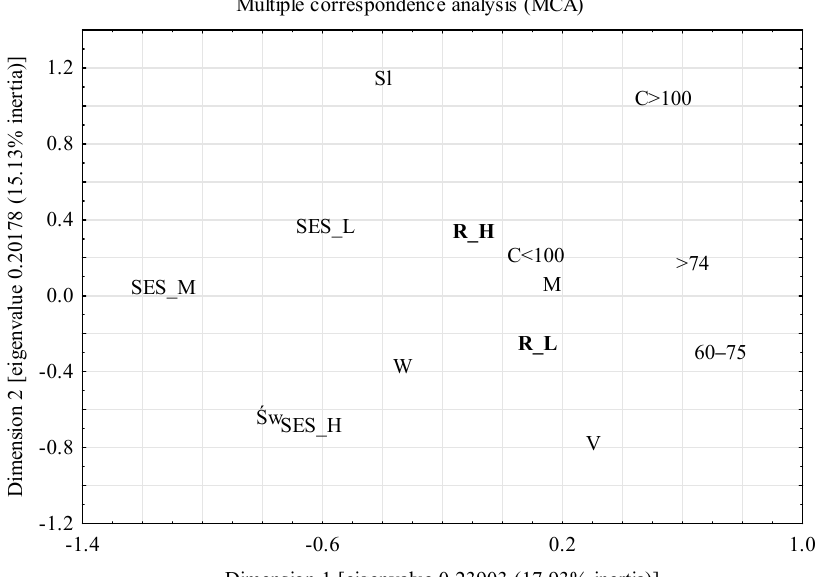
Figure 1. The structure of the relationship between the variables describing nutritional risk, selected demographic features and socioeconomic status. R_H—high nutritional risk; R_L—low nutritional